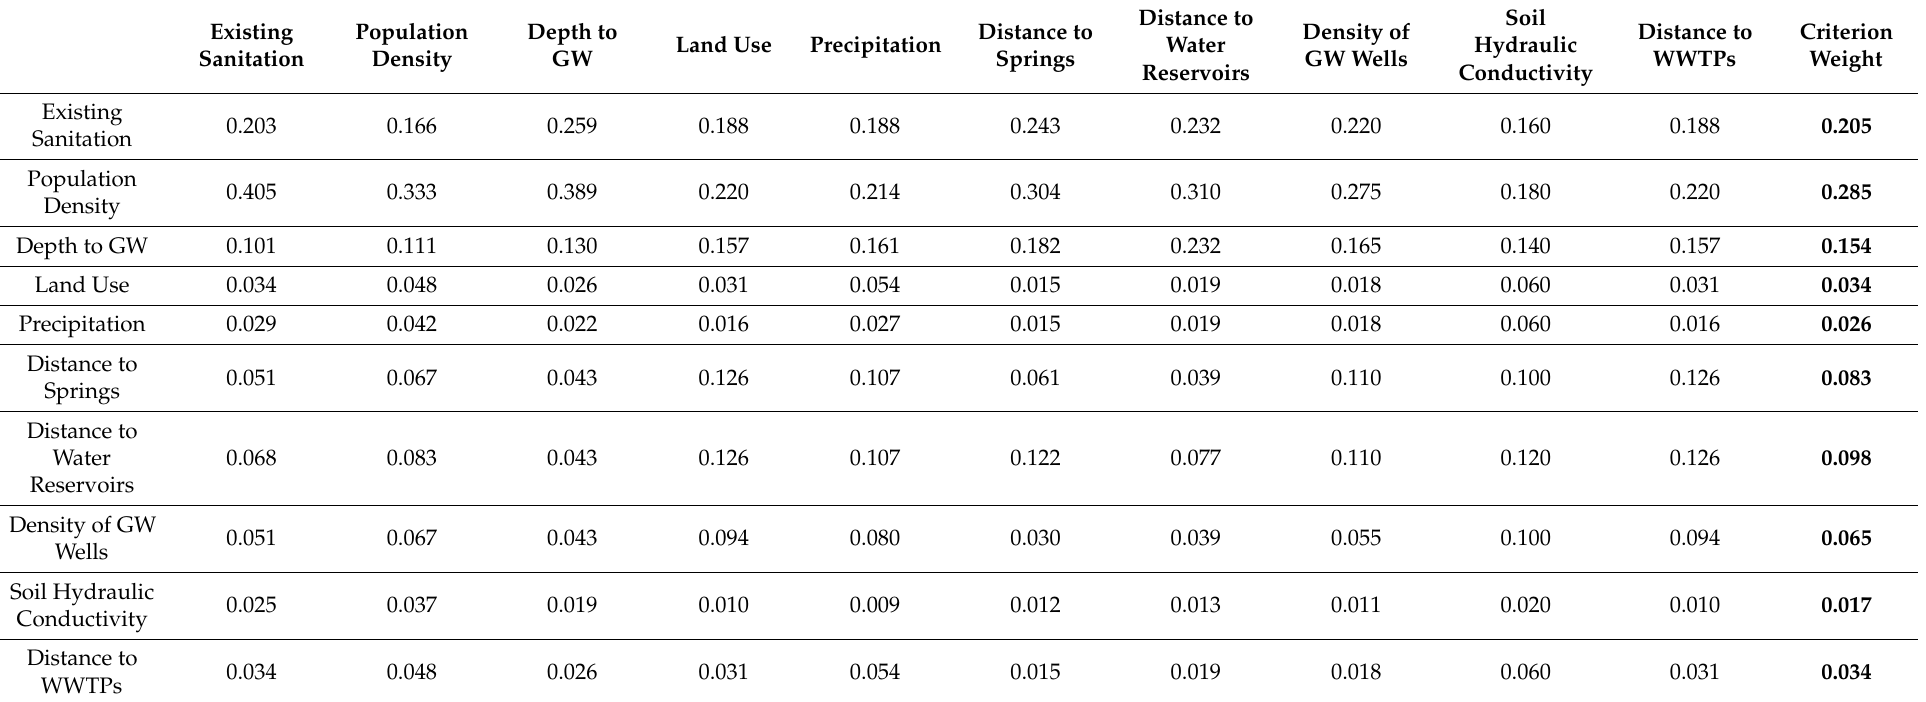
Table 3. Normalized AHP matrix and calculated relative weight for every